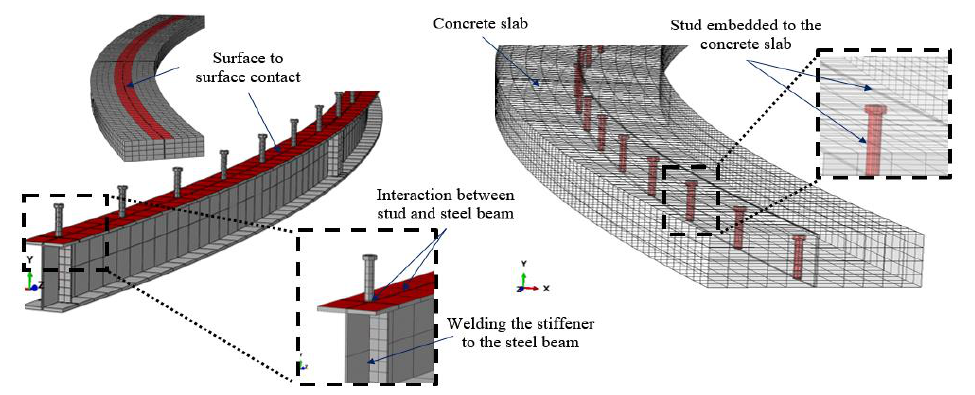
Figure 5. Interaction and the constraint condition in the